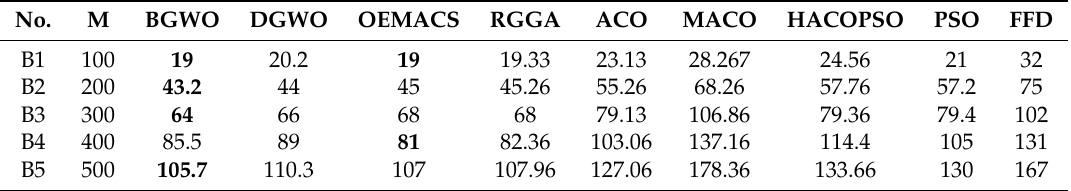
Table 2. Number of active physiacl machines (PMs) for the bottleneck resource test in the heterogeneous environment (the best results are in